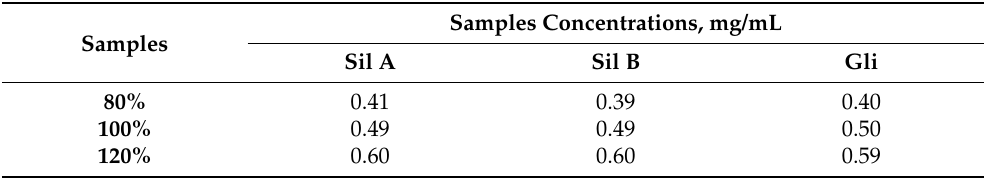
Table 6. The calculated concentrations for accuracy determination of the